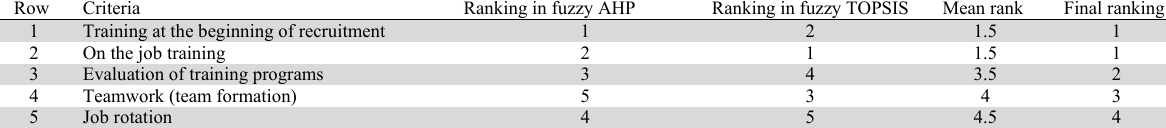
The results of final ranking of main HRM sub-criteria Row Criteria Ranking in fuzzy AHP Ranking in fuzzy TOPSIS Mean rank Training at the beginning of recruitment